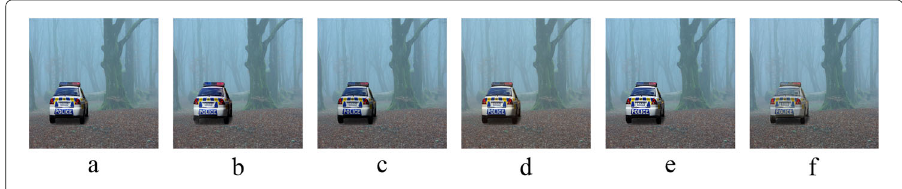
Fig. 1 Comparison of compositing methods on real cut-and-paste image. a Cut-and-paste. b MVCC [1]. c RC [2]. d DIH [3]. e DPH [4]. f Our proposed